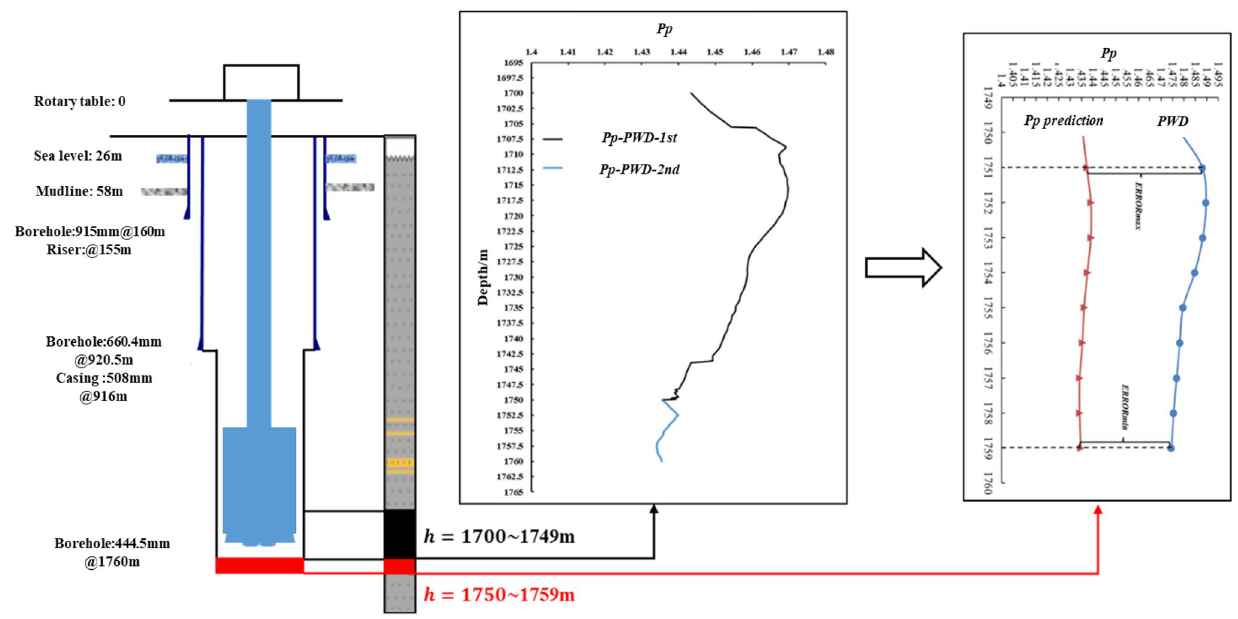
Fig. 3 Flow chart of pressure prediction 10 m in front of bit at 1750 m